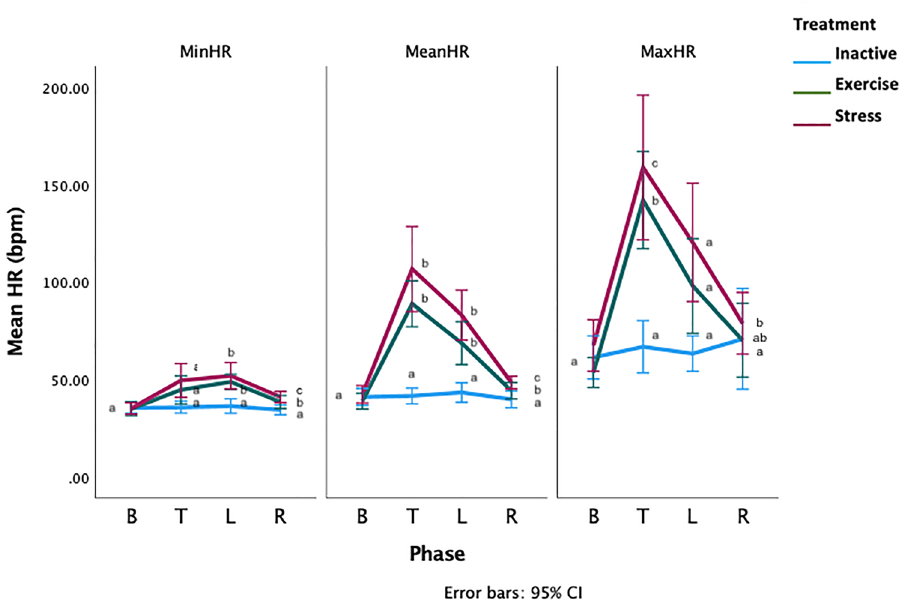
Figure 3. Means of the minimum (MinHR), mean (MeanHR) and maximum (MaxHR) heart rates for the PT = pre-test phase T = treatment phase, L = learning phase. Letters that differ within each phase differ significantly at p < 0.005. Phases without letters do not